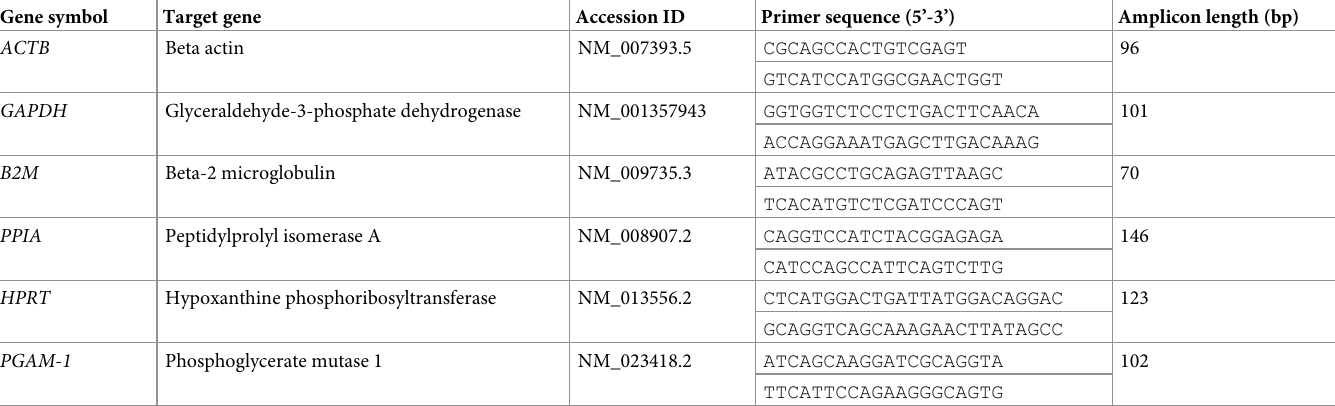
Table 1. Primer sequences for the six candidate genes.